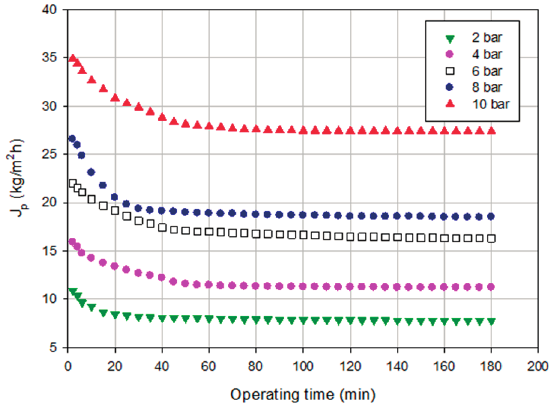
Figure 9. Time course of permeate flux at different TMP values (Desal DK membrane, total recycle configuration, 25